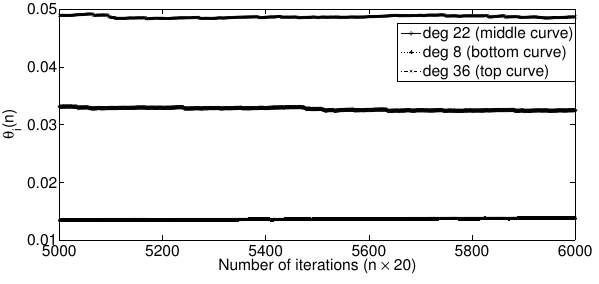
Figure 5: Steady state θ i ( n ) vs n for nodes with max- imum / minimum degrees and for a node with degree close to the average degree.